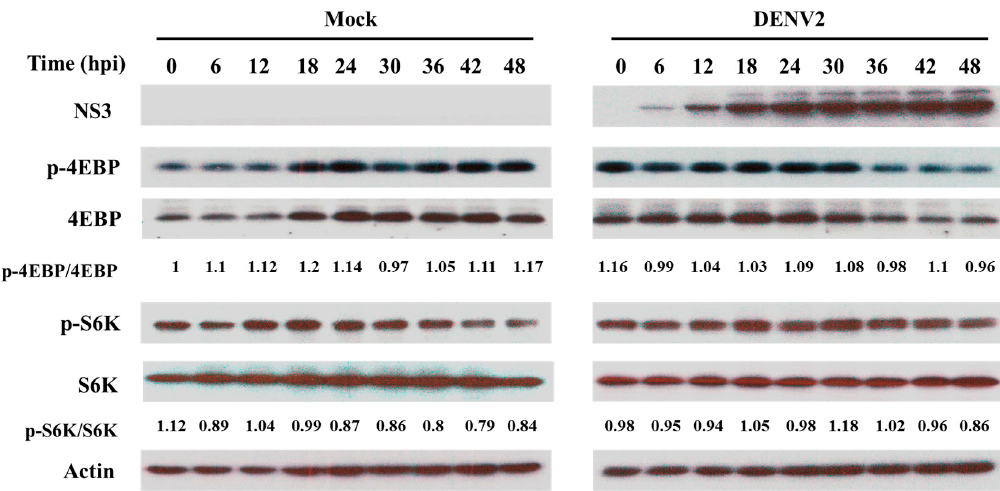
Figure 3. Activation of the target of rapamycin (TOR) signaling pathway by the dengue 2 virus (DENV2) in C6/36 cells. According to the Western blotting analysis carried out in DENV2-infected C6/36 cells, eIF4E-BP was shown to be phosphorylated at a very early stage of infection by the DENV2 (<12 h post-infection (hpi)) and was at a lower level at a later stage of infection (>36 hpi), compatible with a reduction in eIF4E-BP expression. According to the ratio of phosphorylation/total eIF4E-BP, its change of phosphorylated level may be dependent on the expression of eIF4E-BP. One of TOR’s downstream genes, S6 kinase (S6K), was usually phosphorylated particularly at 18 hpi in C6/36 cells, even though its protein level remained at a constant level throughout the same period of infection. In the meantime, NS3 viral proteins were persistently expressed throughout the 48-h infection period. The level of actin was included to prove equal loading of protein in each line. This reveals that the TOR signaling pathway may have been activated and involved in controlling cap-dependent translation of cellular proteins.